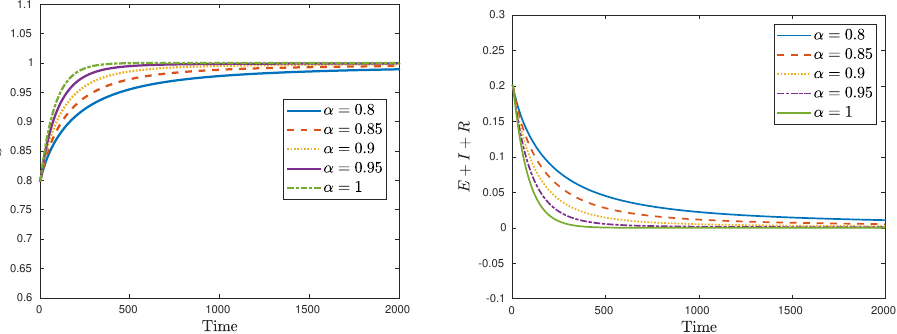
Figure 1. Stability of the disease free equilibrium Σ 0 = ( 1,0, 0,0 ) , for the SEIR fractional model (3), considering different values of α ∈ { 0.8,0.85,0.9,0.95,1.0 } . On the left: S . On the right: E + I + R